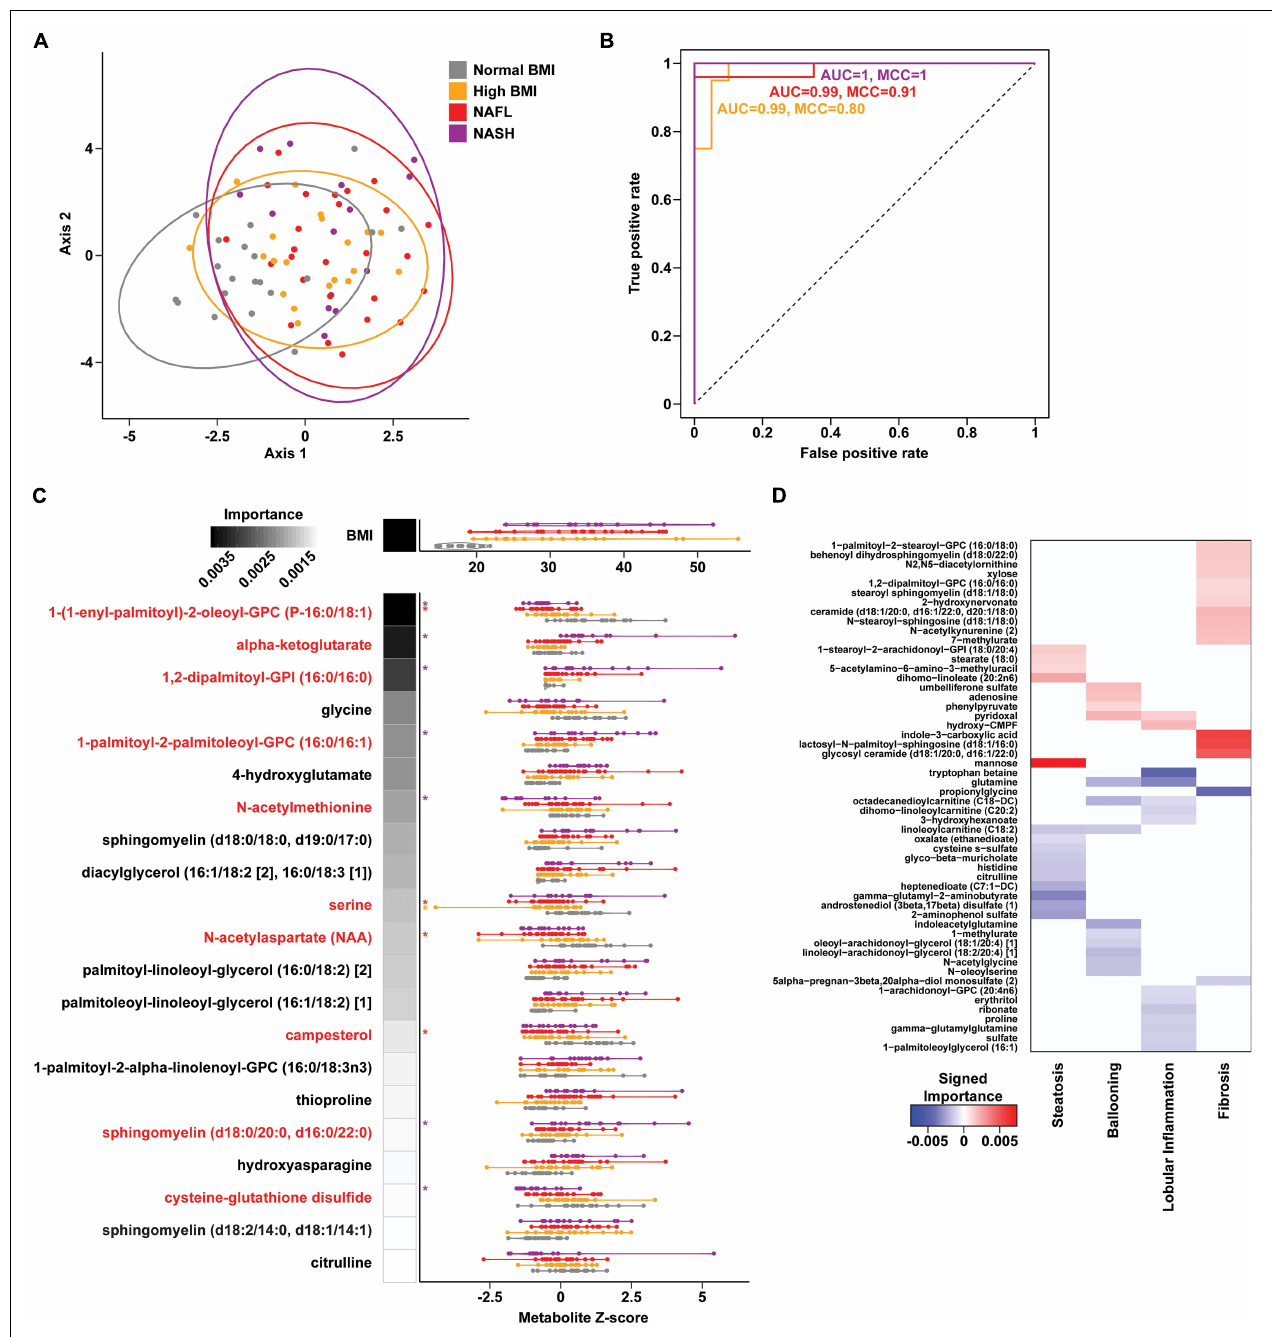
FIGURE 2 | Plasma metabolite signatures of progressive fatty liver disease. (A) T-distributed stochastic neighbor embedding (t-SNE) plot of plasma metabolite profiles. Ellipses show 95% confidence regions for each cohort. (B) Receiver operating characteristic (ROC) curves of binary RF classification models for each group as indicated vs. “Normal BMI” baseline. (C) Distribution of BMI and metabolite values for the features selected in the multiclass RF model (violin plots). RF model importance values are shown as shaded boxes with darker colors denoting higher mean importance. Red text denotes metabolites identified as significantly altered in linear regression models. (D) Heatmap of importance values for RF models of liver histology findings. Positive (red) and negative (blue) values indicate metabolites that are increased and decreased with higher grades of each finding, respectively.